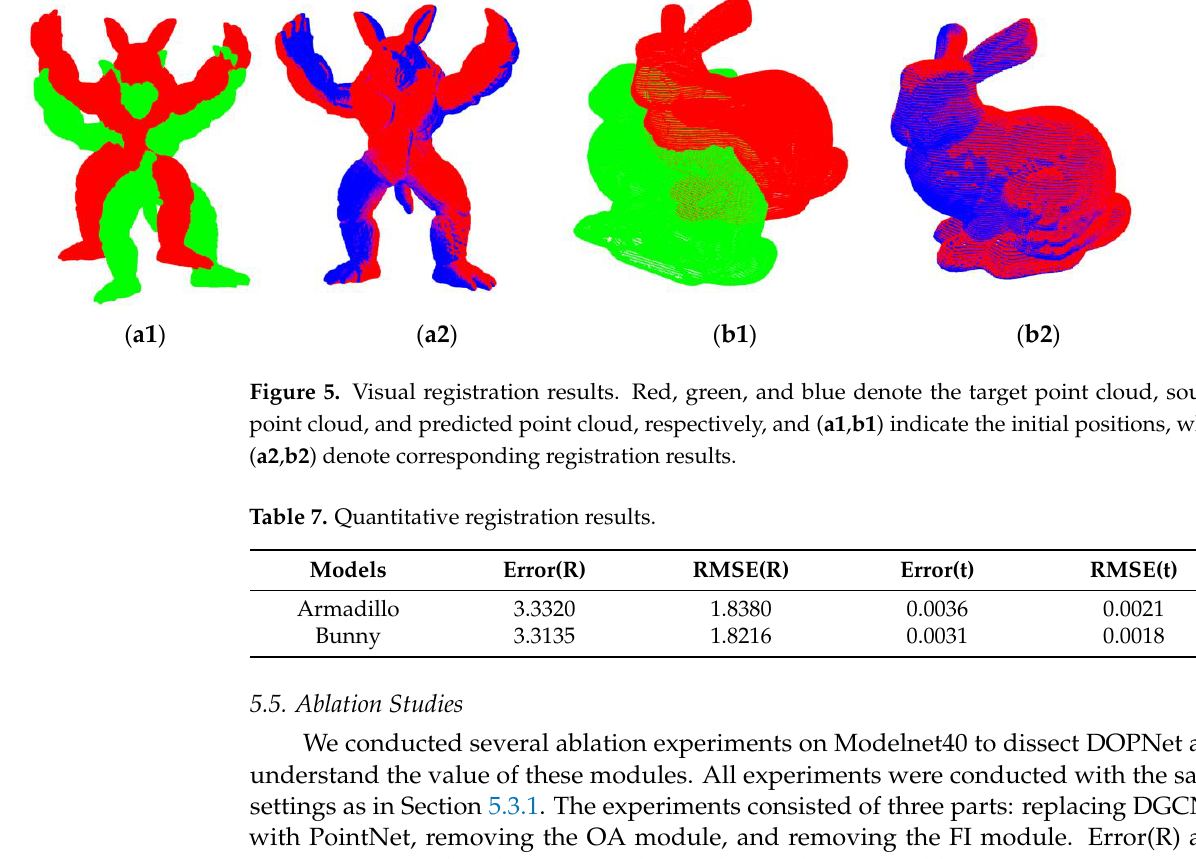
Table 8. Ablation